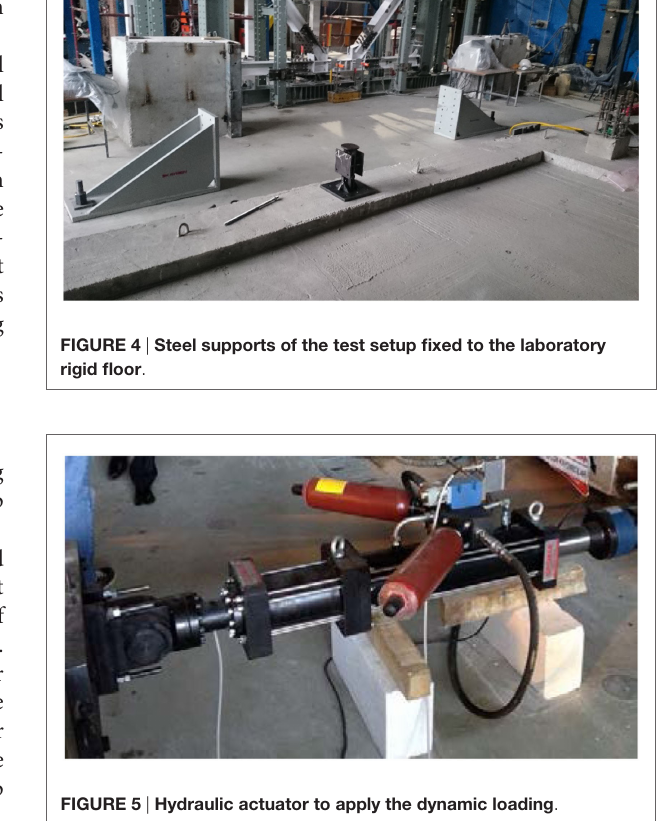
FigUre 5 | hydraulic actuator to apply the dynamic loading .